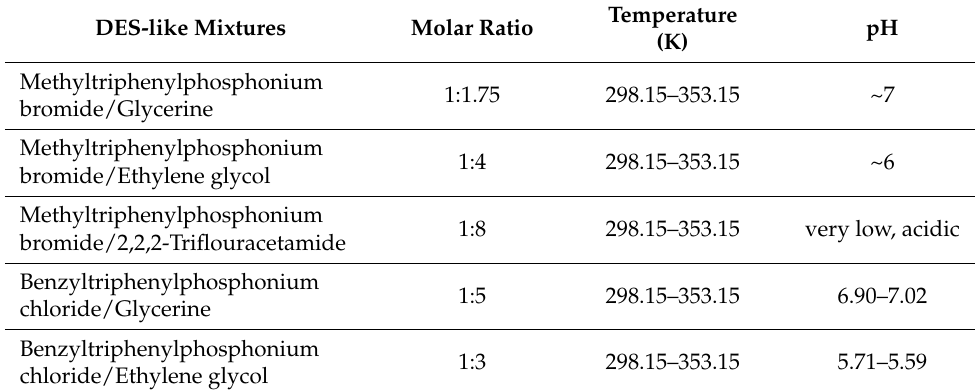
Table 4. Molar ratios, temperature, and pH values of prepared DES-like mixtures (adapted according to Kareem et al.)